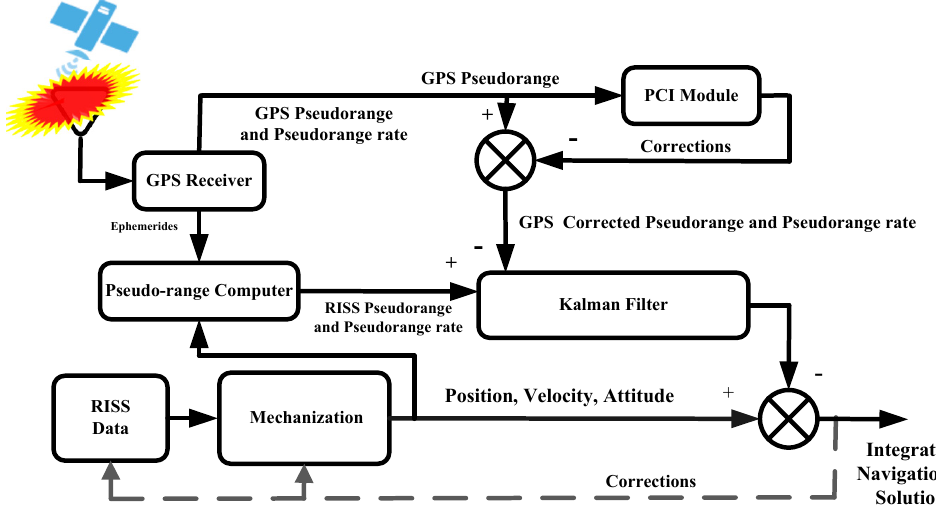
Figure 13. Tightly coupled KF-PCI technique during partial GNSS outage. Around a 3000 s long trajectory was considered to check the validity of the proposed technique. It started at the Royal Military College of Canada, covering the major roads in the city of Kingston. Six 60 s GNSS outages were introduced in post-processing during good GNSS availability, as shown in Figure 14 on the map as blue circles.